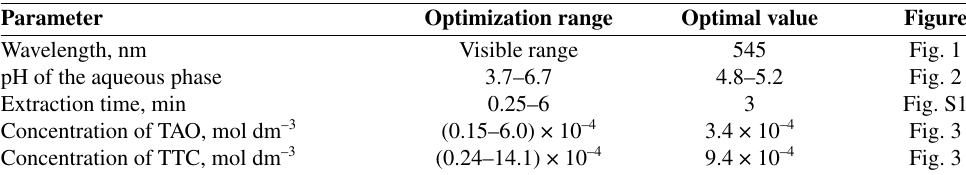
Table 1. Extraction-spectrophotometric optimization of the V(V)-TAO-TTC-water-chloroform system Parameter Optimization range Wavelength, nm Visible range pH of the aqueous phase Extraction time,